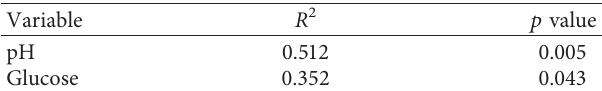
Table 3: Coefficient factors and the significance of the proposed model for predicting hypoechogenicity index